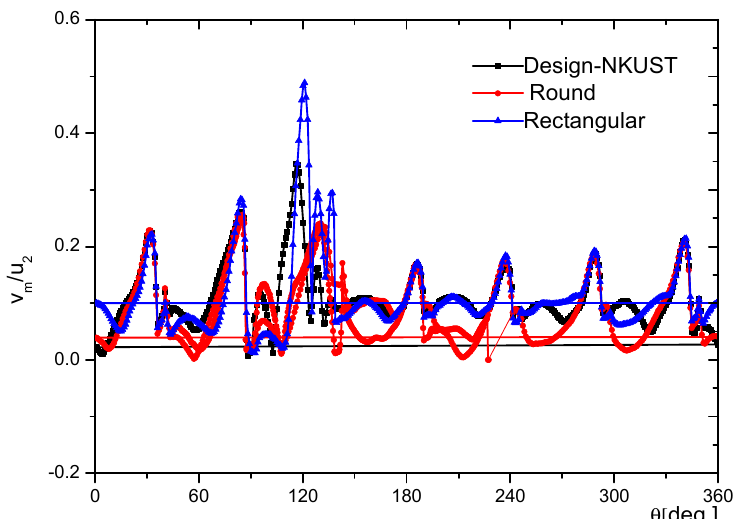
Figure 11. Static pressure coefficient at the volute inlet to three cross-sectional shapes.